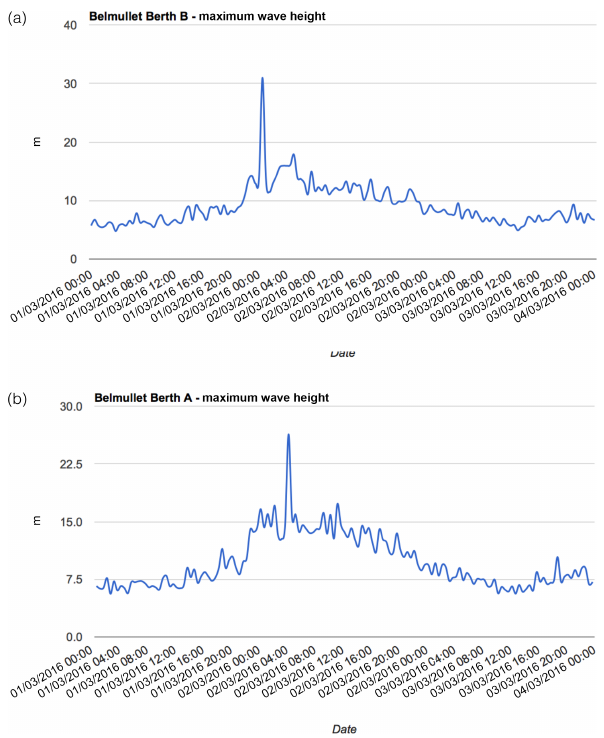
Figure 16. Maximum wave height at (a) Belmullet Berth B and (b) Belmullet Berth A wave buoys on 1–3 March 2016. Data retrieved from The Marine Institute (2017a). Dates are day/month/year.